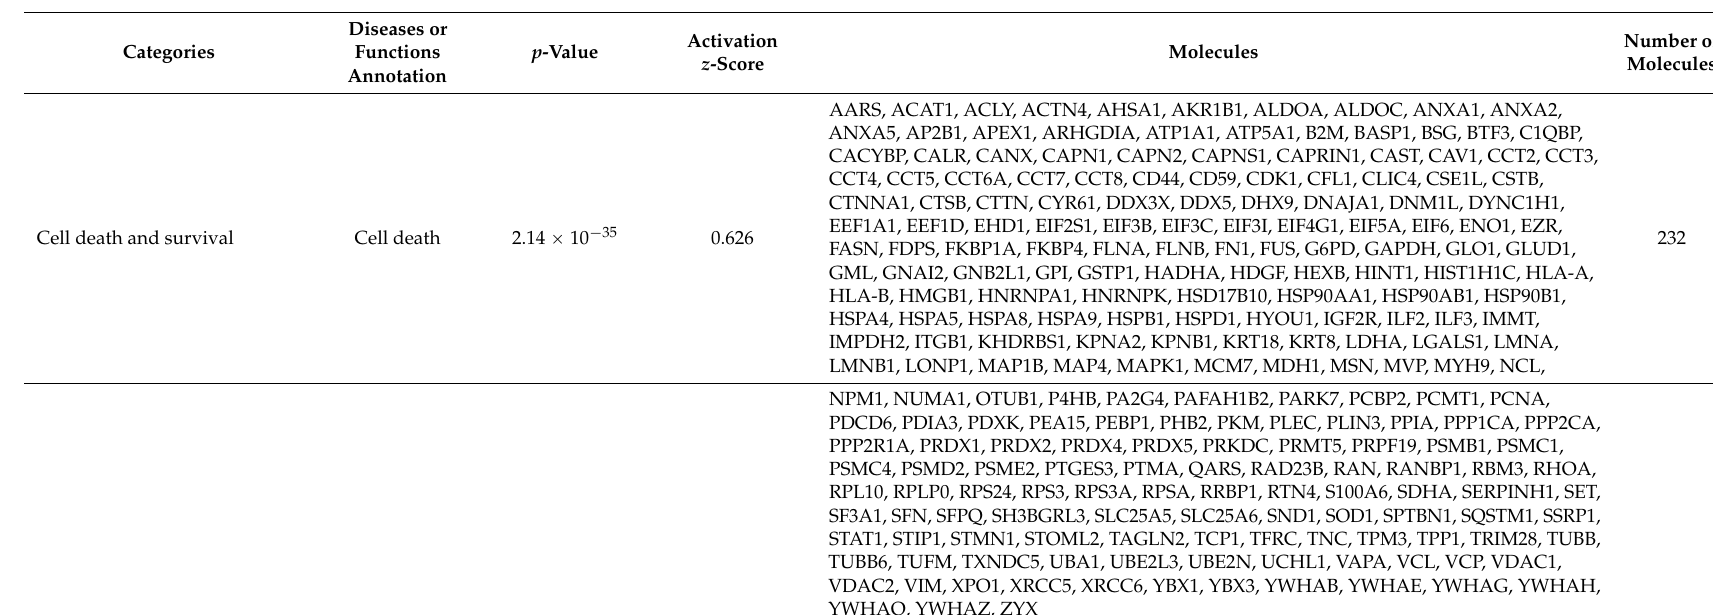
Table 5. 500 categories of predicted diseases and functions regulated by vancomycin in HK-2